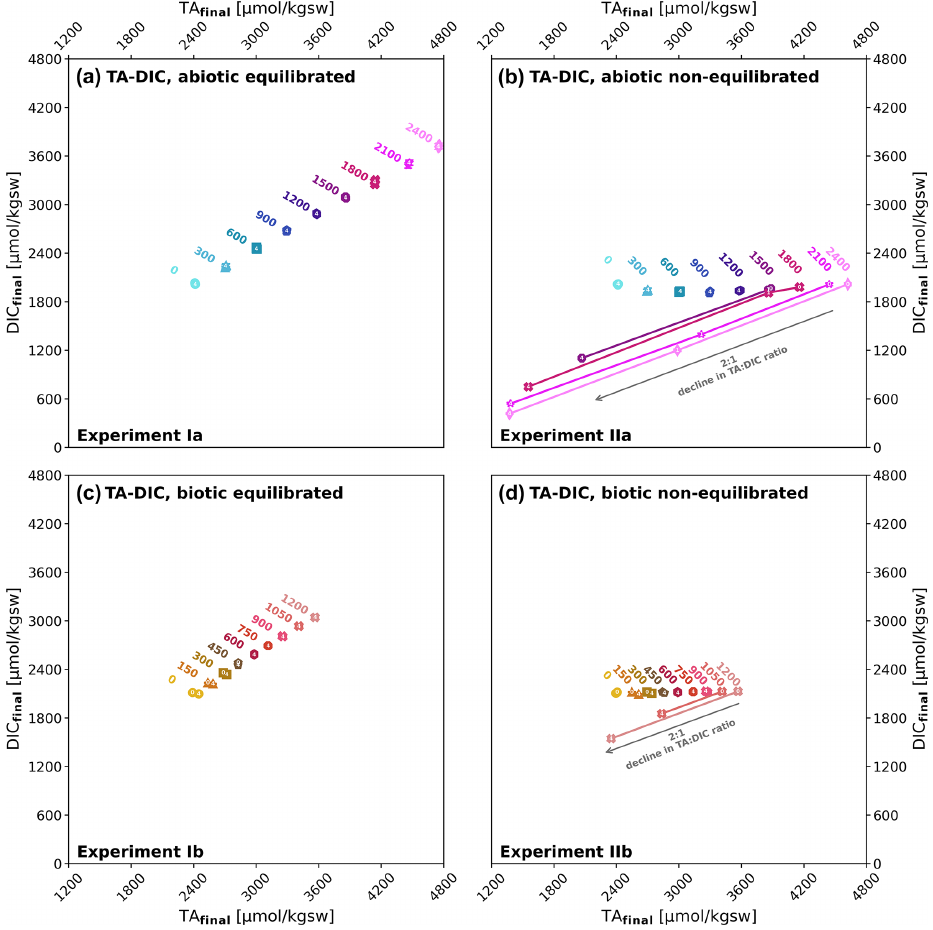
Figure 3. TA final versus DIC final at the start of the experiments I and II and after precipitation: (a–b) abiotic after 0, 1, and 4d; (c–d) biotic after 0 and 4d, equilibrated alkalinization (left, experiment I) and non-equilibrated alkalinization (right, experiment II). The TA:DIC change ratio of 2 : 1 indicates that alkalinity loss was due to carbonate precipitation. Sampling days (0, 1, and 4) are written on top of each data point marker. Due to overlapping in case of no change in data, the marker description is set as up to down. The grey arrows in (b) and (d) indicate an ideal 2 : 1 decline in